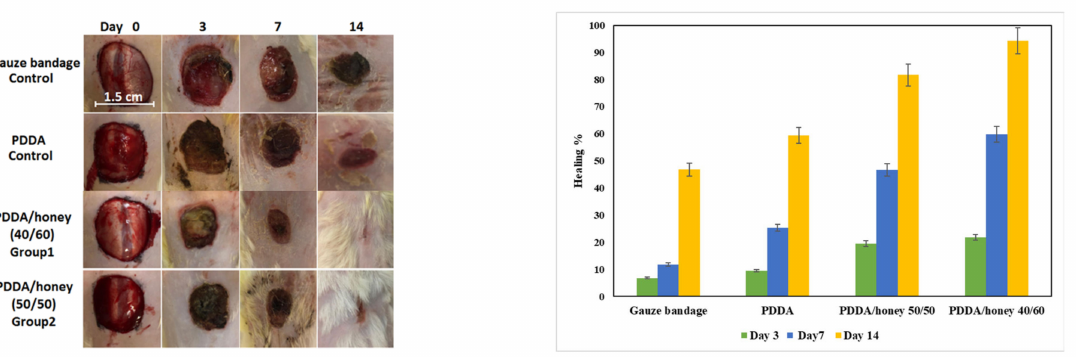
Figure 6. Images of generated wounds after treatment with nanofibers for different durations of 0, 3, 7, and 14